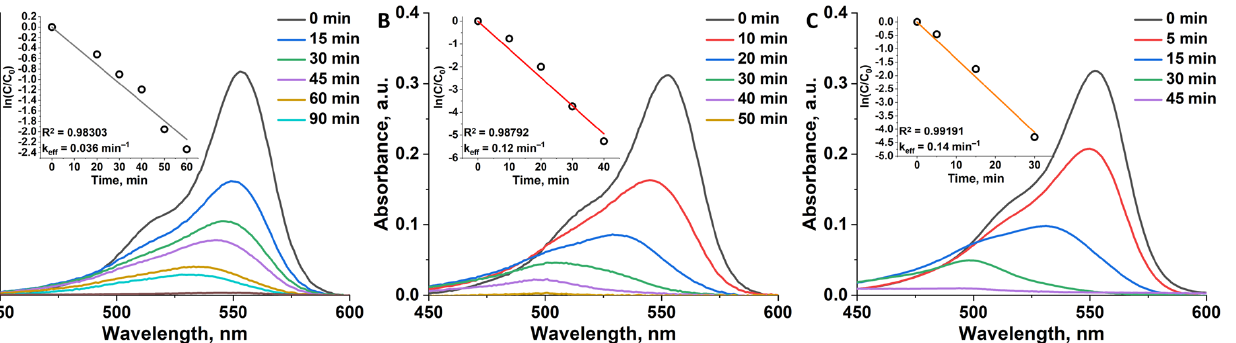
Figure 7. Absorption spectra of RhB solution before and after irradiation with sunlight (~30–35 mW cm −2 ) in the presence of TiO 2 ( A ), 1 0.1 @TiO 2 ( B ), and 2 0.1 @TiO 2 ( C ) during different time intervals. Inserts are linear approximation of ln(C/C 0 ) vs. time plots used for determination of k eff .